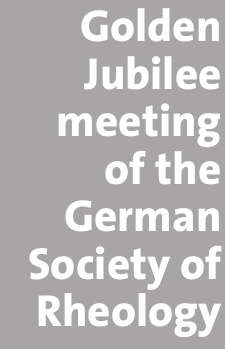
Figure 6: Creep compliance Jcr(tcr) and creep recovery compliance Jrec(trec, tcr, 0) for a very low shear stress of t = 0.19 Pa (system Mono 1200/PIB 1, F